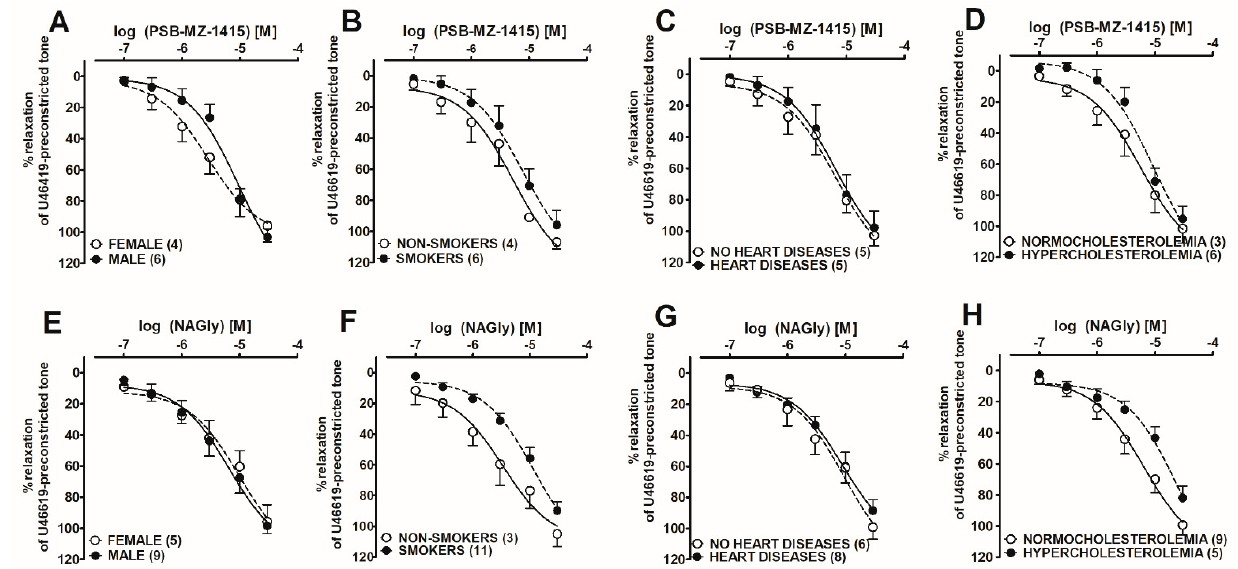
Figure 4. Post hoc analysis of the effect of sex and co-morbidities on PSB–MZ–1415–( A – D ) and NAGly–( E – H ) mediated vasorelaxation in endothelium-intact isolated human pulmonary arteries. The results are presented as the mean ± SEM of n (given in parentheses) tissue samples for each curve. Student’s t -test for unpaired data was used to compare the curves (pEC50 values). ( A ) p = 0.0096; ( B ) p = 0.2133; ( C ) p = 1.0; ( D ) p = 0.2524; ( E ) p = 0.2197; ( F ) p = 0.0174; ( G ) p = 1.0; ( H ) p = 0.0022. See Table 3 for further details. Table 3. Patient characteristics, diagnosis, types of operations, medications and post hoc analysis of the effect of sex and co-morbidities on PSB-MZ-1415- and NAGly-mediated vasorelaxation in isolated human pulmonary arteries.